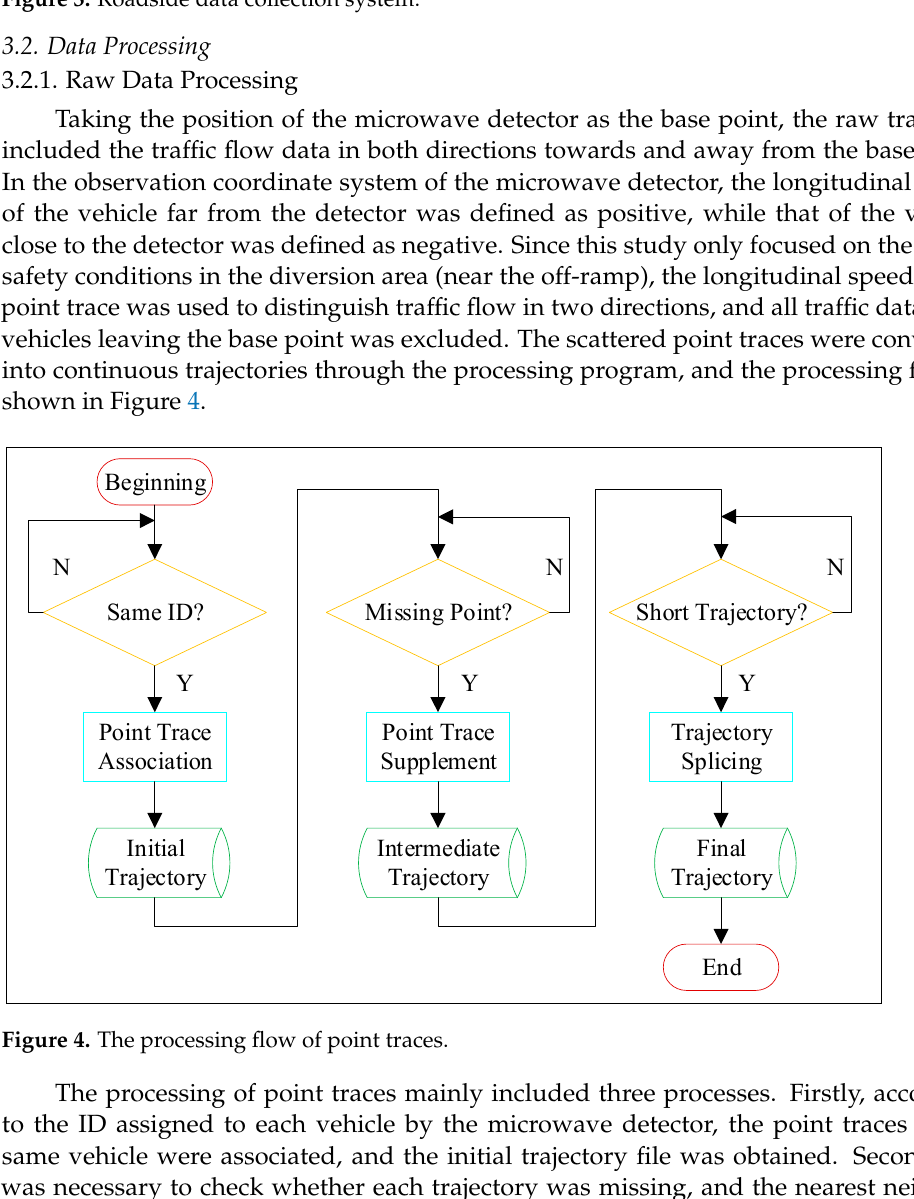
Figure 3. Roadside data collection system.